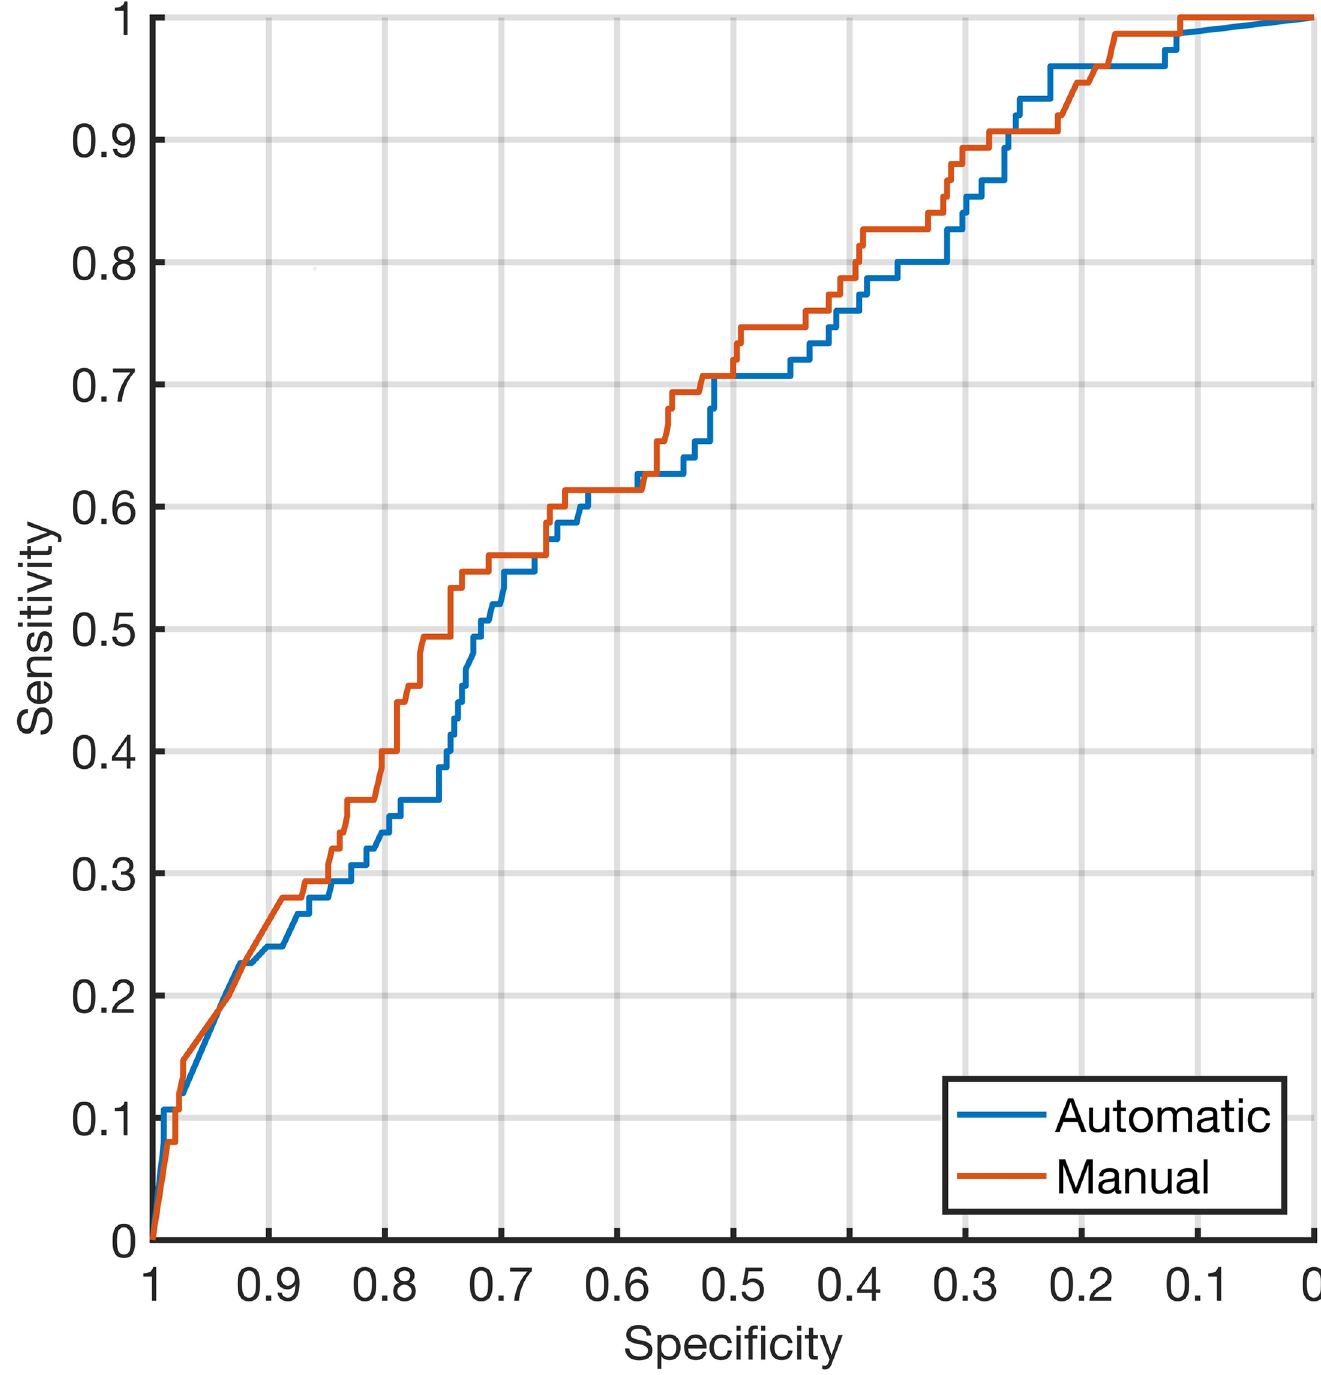
Fig 2. ROC curves for different segmentation methods. ROC curves for Nevus Doctor with automatic and semi-automatic/manualsegmentation.